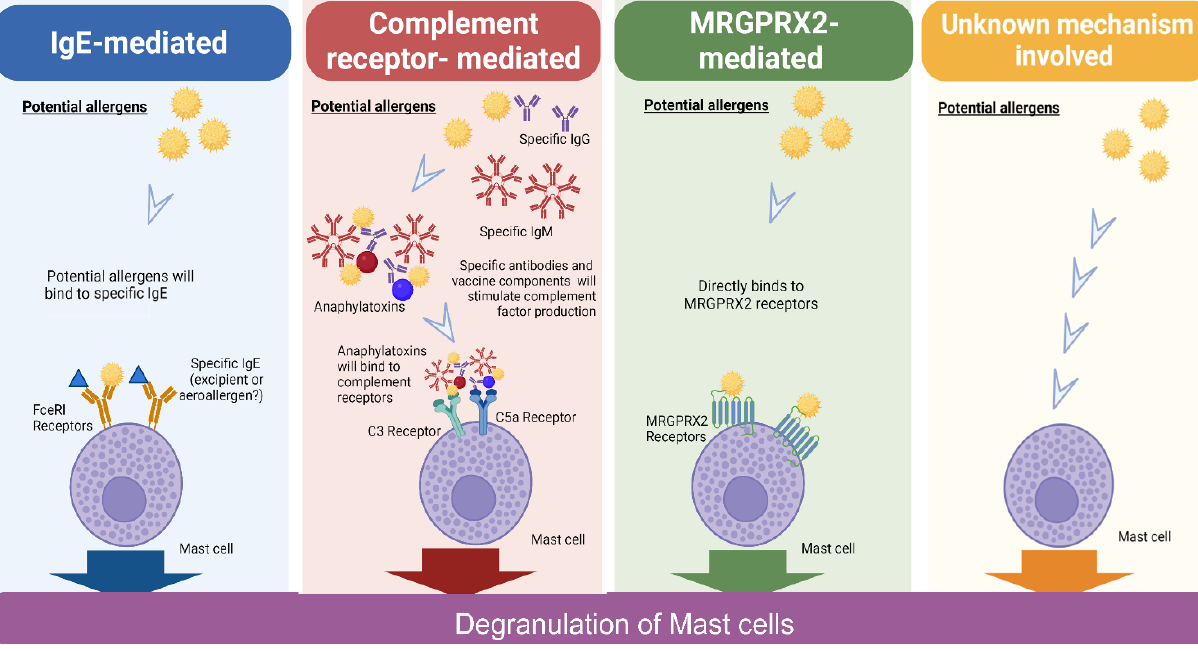
Figure 1. Proposed mechanisms for immediate hypersensitivity reactions. There are four proposed mechanisms for immediate hypersensitivity: IgE-mediated, complement-receptor-mediated, Mas-related G protein-coupled receptor X2 (MRGPRX2)-mediated mast cell activation, and an unknown mechanism. Binding of allergens from the components of vaccines to antibodies or receptors may initiate the hypersensitivity reactions. The specific IgE antibodies recognize the active compo- nents or excipients of the vaccines. IgE antibodies are then coupled with receptor- FcεRI on the mast cells, resulting in mast cell degranulation. These specific IgE antibodies may be brought by previous exposure to allergens in cosmetics, drugs, aeroallergens, or food. Vaccine components may activate the complement-receptor-mediated pathway and induce anaphylatoxins that could be recognized by complement receptors on the mast cells. In addition, binding of the vaccine components and excipients to MRGPRX2 receptor may directly activate mast cells. Furthermore, immediate hyper- sensitivity reactions may be induced by an unknown mechanism. These proposed mechanisms could lead to mast cell degranulation and the release of effector mediators. Abbreviation: MRGPRX2, Mas-related G protein-coupled receptor X2; IgE, immunoglobulin E; PEG, polyethylene glycol. Many of the immediate hypersensitivity reactions are considered IgE-mediated, sup- ported by skin prick tests and specific IgE levels [65]. Several excipients have been sug- gested to trigger the production of specific IgE antibodies and cause mast cell activation [65]. Patients with specific IgE antibodies against vaccine antigens may have higher risks